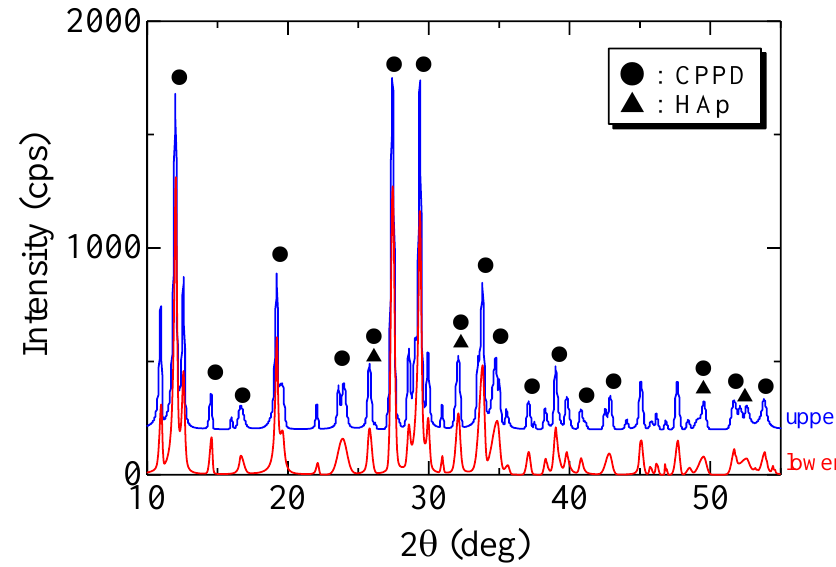
Figure 9. X-ray diffraction. The blue and red wavelengths represent the specimens extracted from the upper and lower joint cavities, respectively. The circles and triangles indicate the intrinsic peaks of calcium pyrophosphate dihydrate (CPPD) and hydroxyapatite (HAp), respectively.